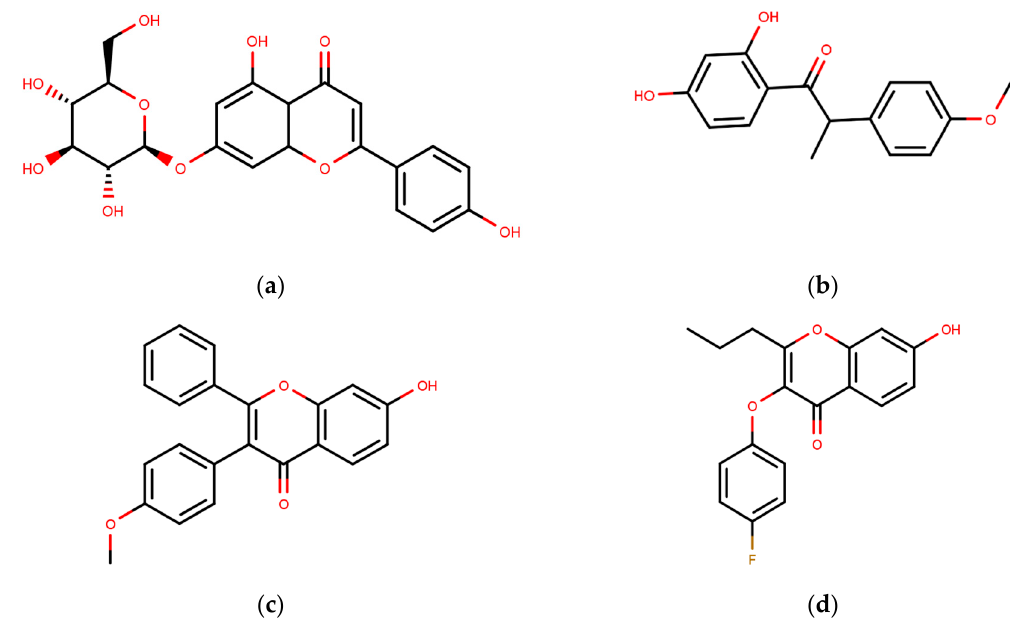
Figure 16. ( a ) Cosmosiin; ( b ) angolesin; ( c ) Compound 9; and ( d ) Compound 10.